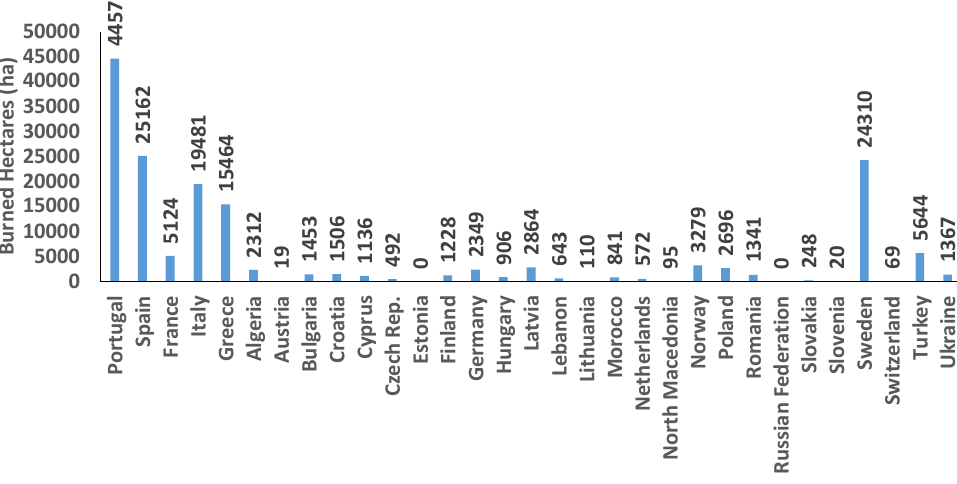
Figure 2. Burned hectares by wildfires in Europe, the Middle East, and North Africa in 2018.